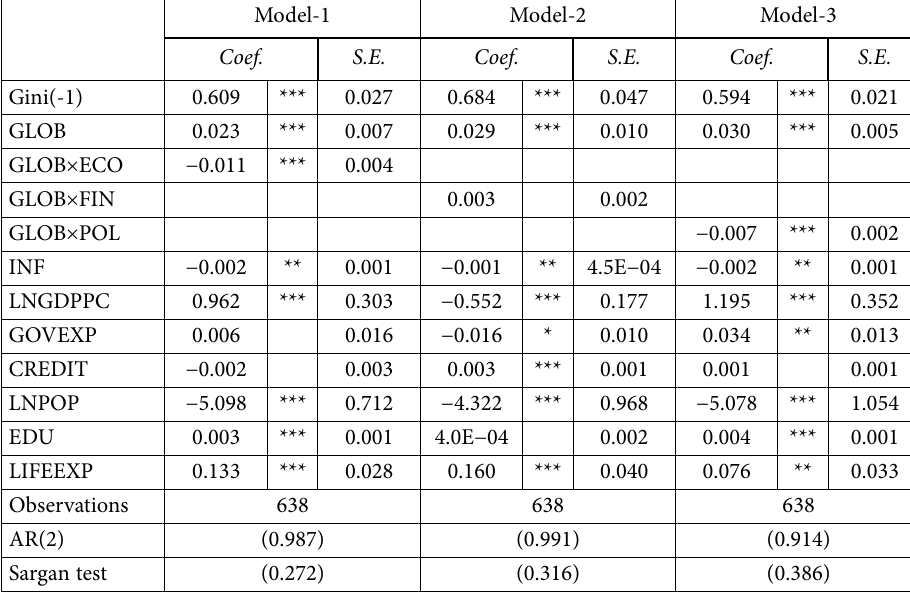
Table 9. Inequality, globalization, and country risk (high-income group) Model-1